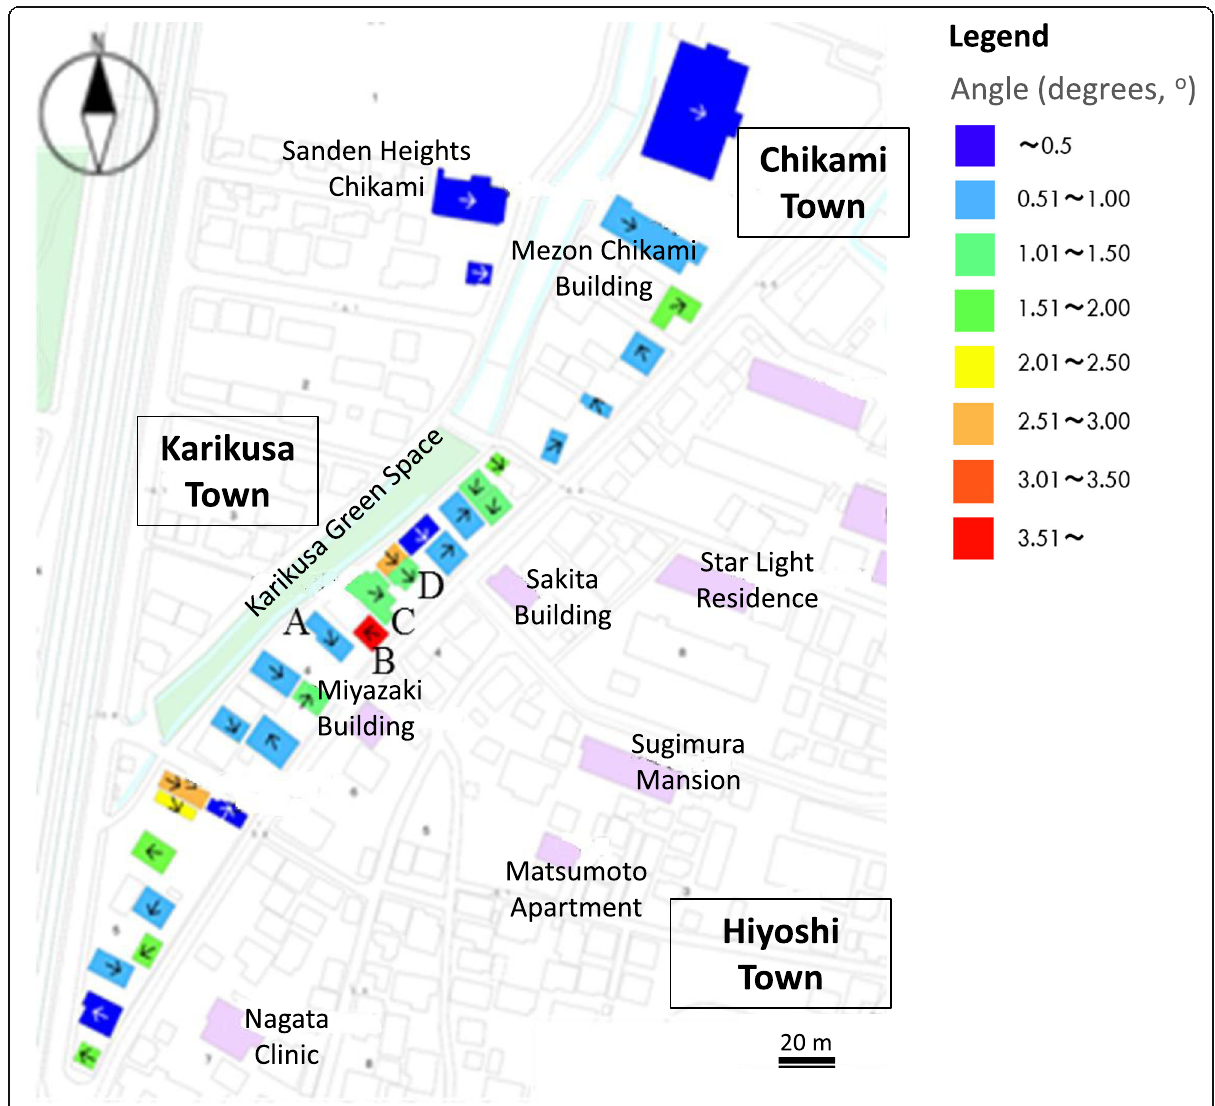
Fig. 19 The tilt angle and direction measurement result in Karikusa